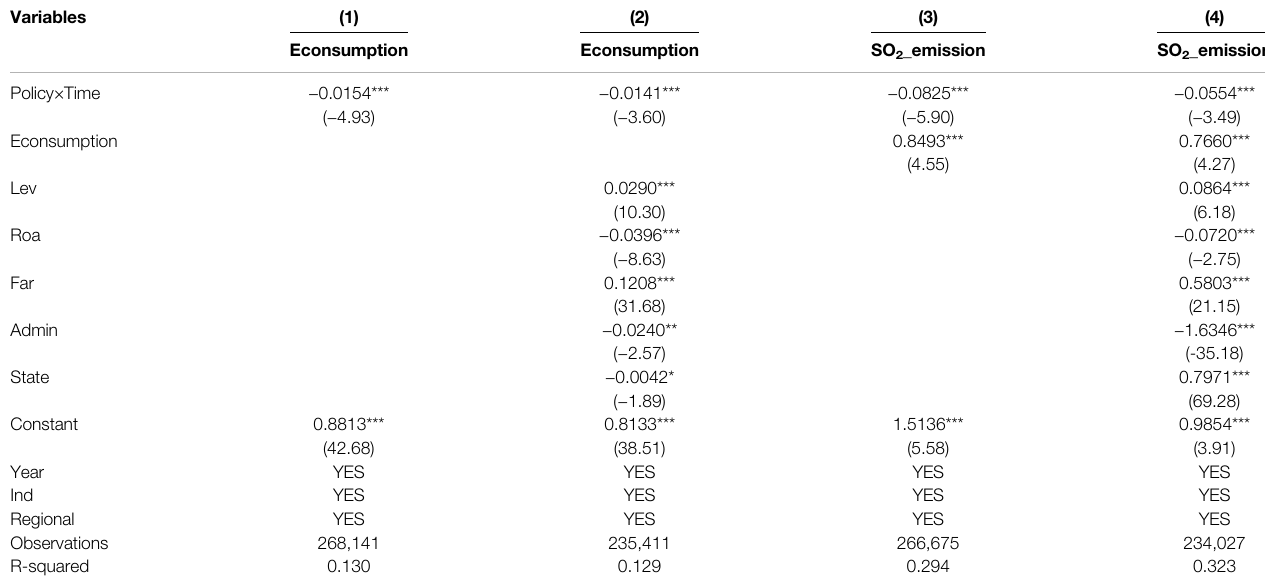
TABLE 6 | Mediation effect estimation results: energy consumption as mediator. Variables